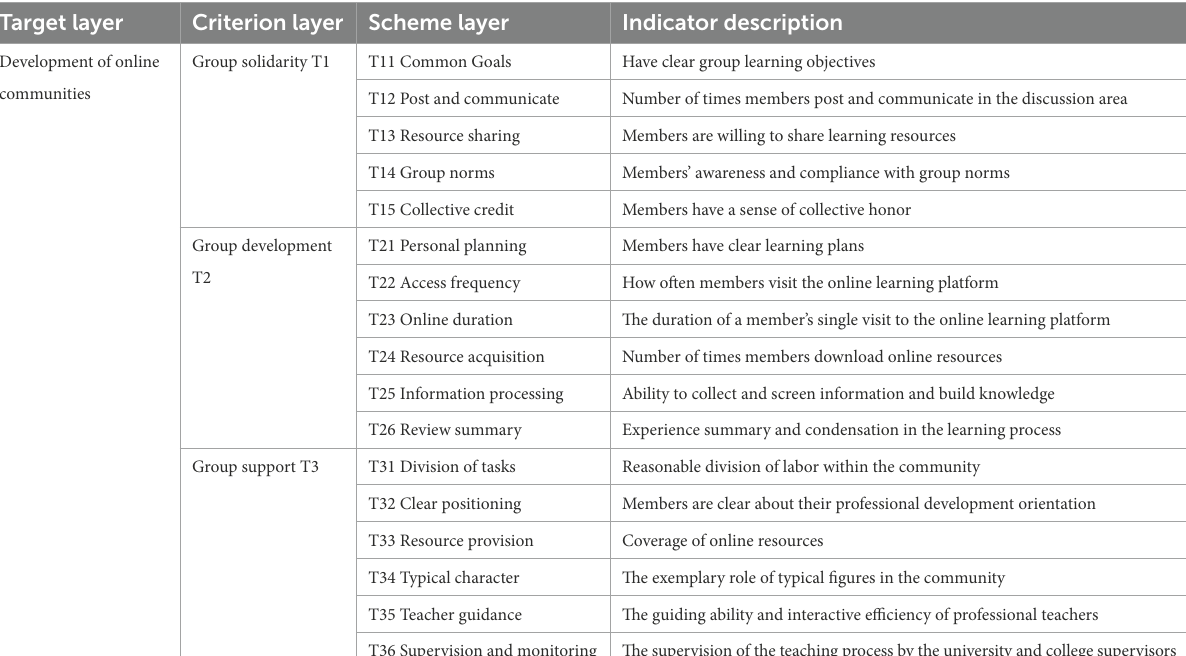
TABLE 1 The hierarchical model of influencing